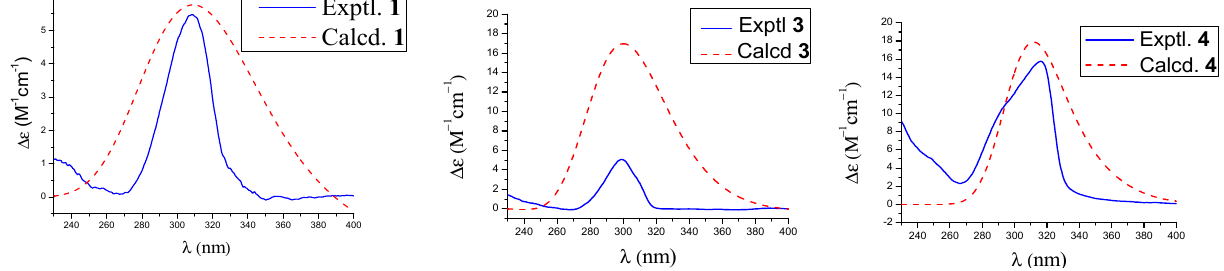
Figure 3. Calculated and experimental ECD spectra of 1 , 3 and 4